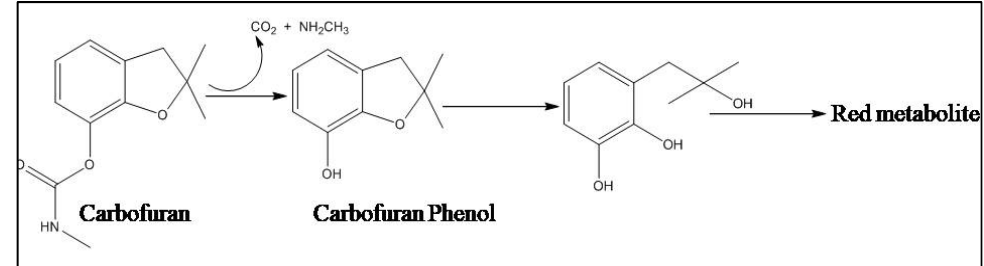
Figure 5. Bacterial degradation pathway of carbofuran by Pseudomonas [209].